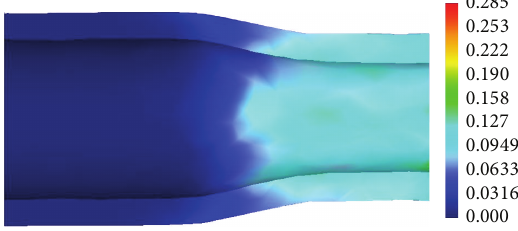
Figure 8: Contours of